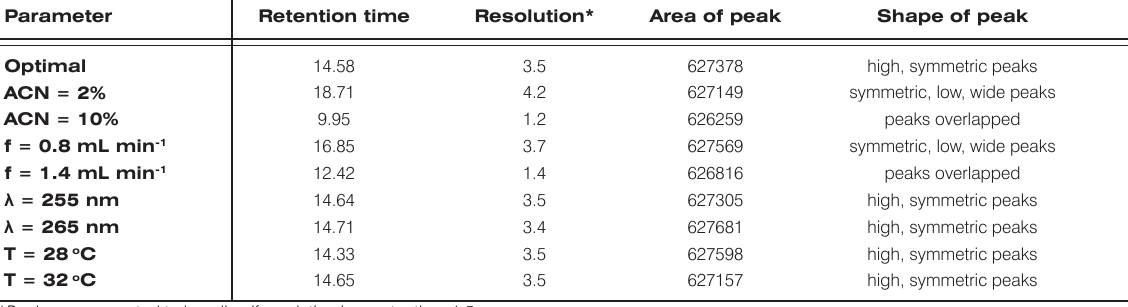
Table 3. Results of robustness studies.